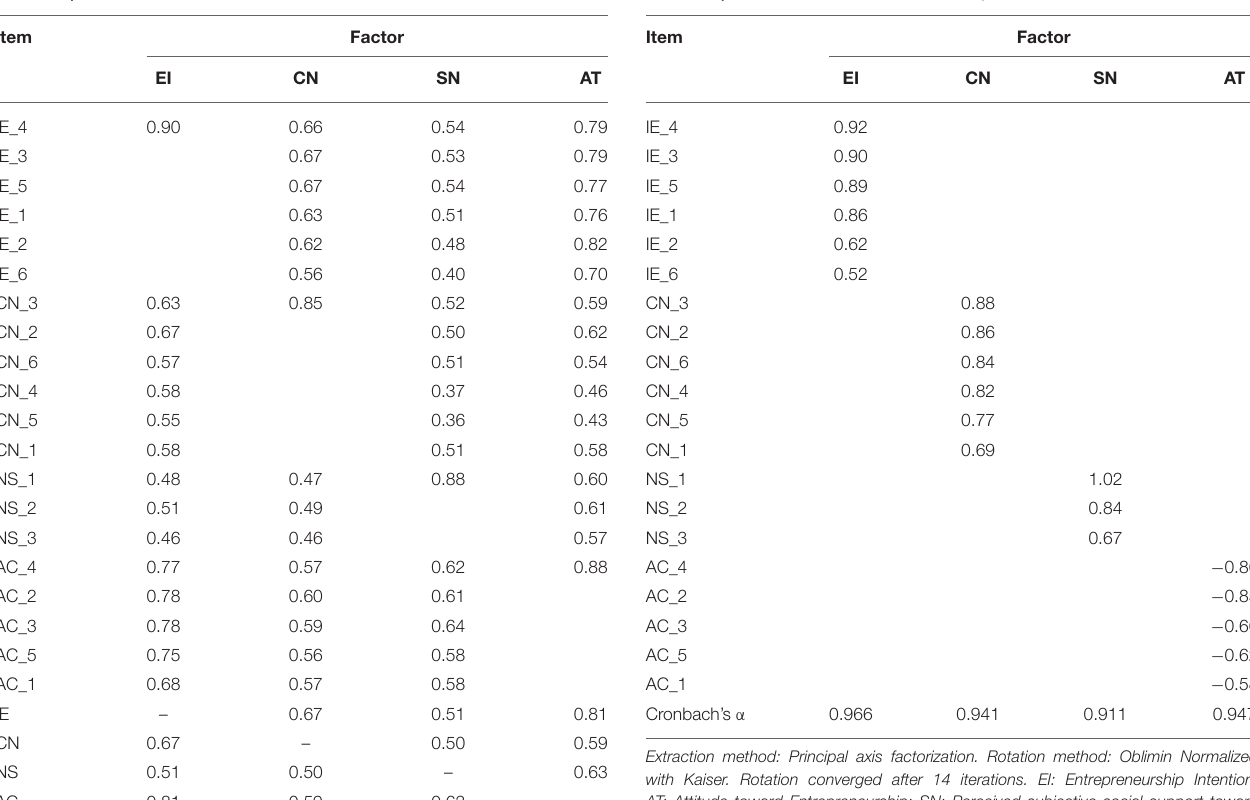
TABLE 2 | Item-construct correlation. TABLE 3 | Rotated factor matrix and reliability